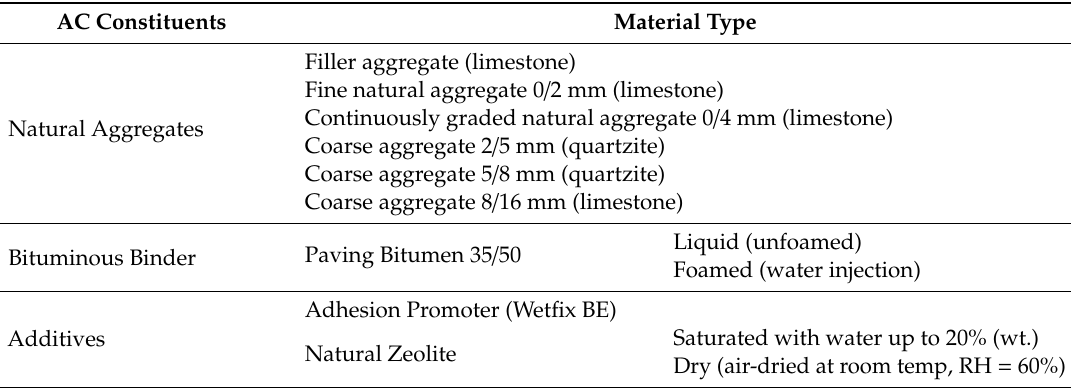
Table 1. The framework composition of the evaluated AC 16